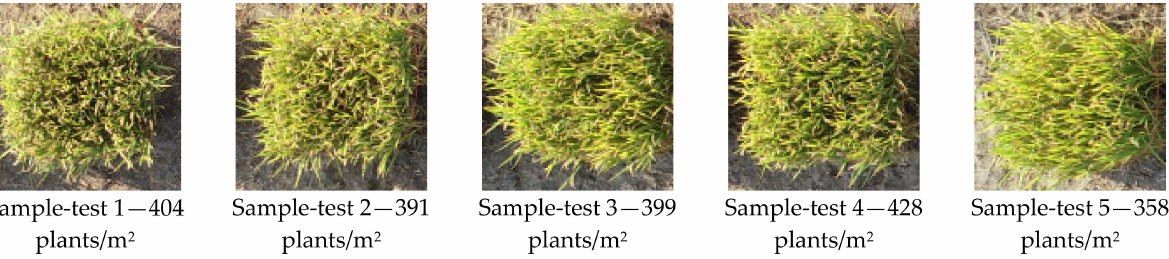
Figure 3. Random experiment group with mature-rice densities randomly selected in the field.